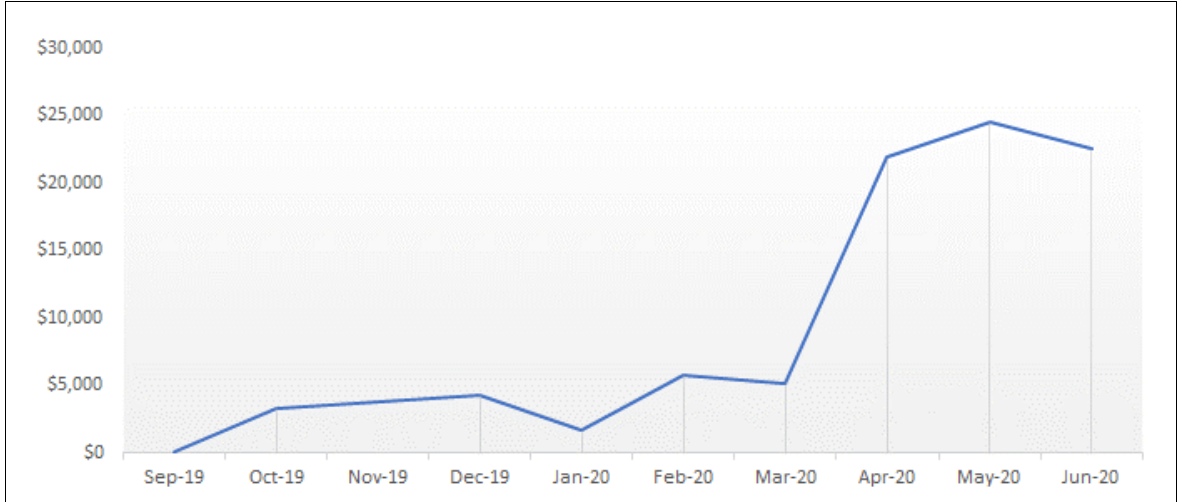
Figure 3. Purchases from Hawai‘i Island by Kahumana Farm Hub, Situated on O‘ahu Island ,